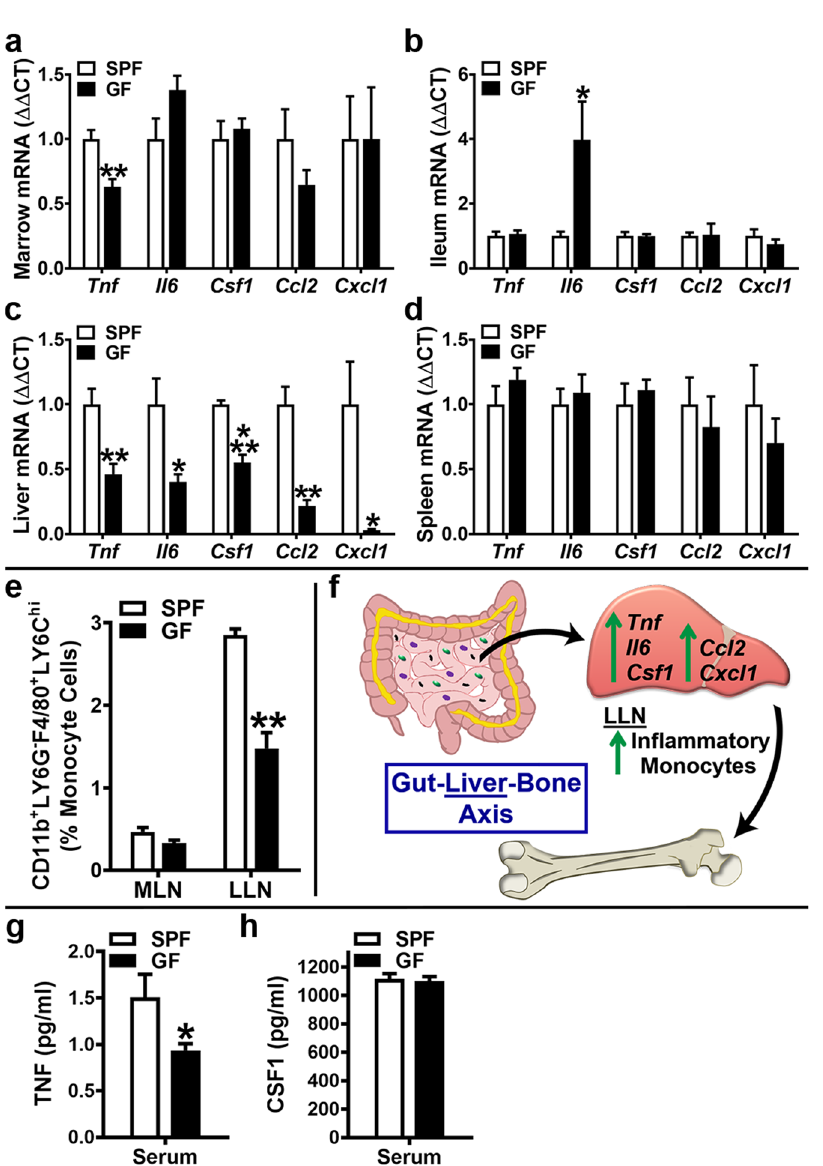
Figure 5. Commensal microbiota in vivo regulation of pro-inflammatory cytokines. 11 to 12 week-old male SPF & GF mice were euthanized; tissues harvested for ( a – d ) gene expression assays, ( e ) flow cytometry assays, and ( g , h ) ELISA assays. ( a – d ) RNA was isolated from tissues and qRT-PCR analysis was performed in ( a ) bone marrow (n = 4/gp), ( b ) ileum (n = 6/gp), ( c ) liver (n = 6/gp), ( d ) spleen (n = 4/gp) to assess Tnf , Il6 , Csf1 , Ccl2 , Cxcl1 mRNA. Relative quantification of mRNA was performed via the comparative C T method ( ΔΔ CT); Gapdh was utilized as an internal control gene; data expressed as fold difference relative to SPF. ( e ) Mesenteric lymph node (MLN) cells and liver lymph node (LLN) cells were isolated and stained for flow cytometric analysis (n = 4/ gp) to assess the frequency of CD11b + LY6G - F4/80 + LY6C hi (inflammatory monocyte) cells. Cell percentages are expressed relative to total gated monocyte cells. ( f ) Schematic of newly identified/proposed Gut-Liver-Bone Axis. ( g , h ) Serum was isolated from whole blood (n = 9–10/gp); ELISA analysis of ( g ) TNF levels and ( h ) CSF1 levels. Data are reported as mean ± SEM. * p < 0.05 vs. SPF; ** p < 0.01 vs. SPF; *** p < 0.001 vs.